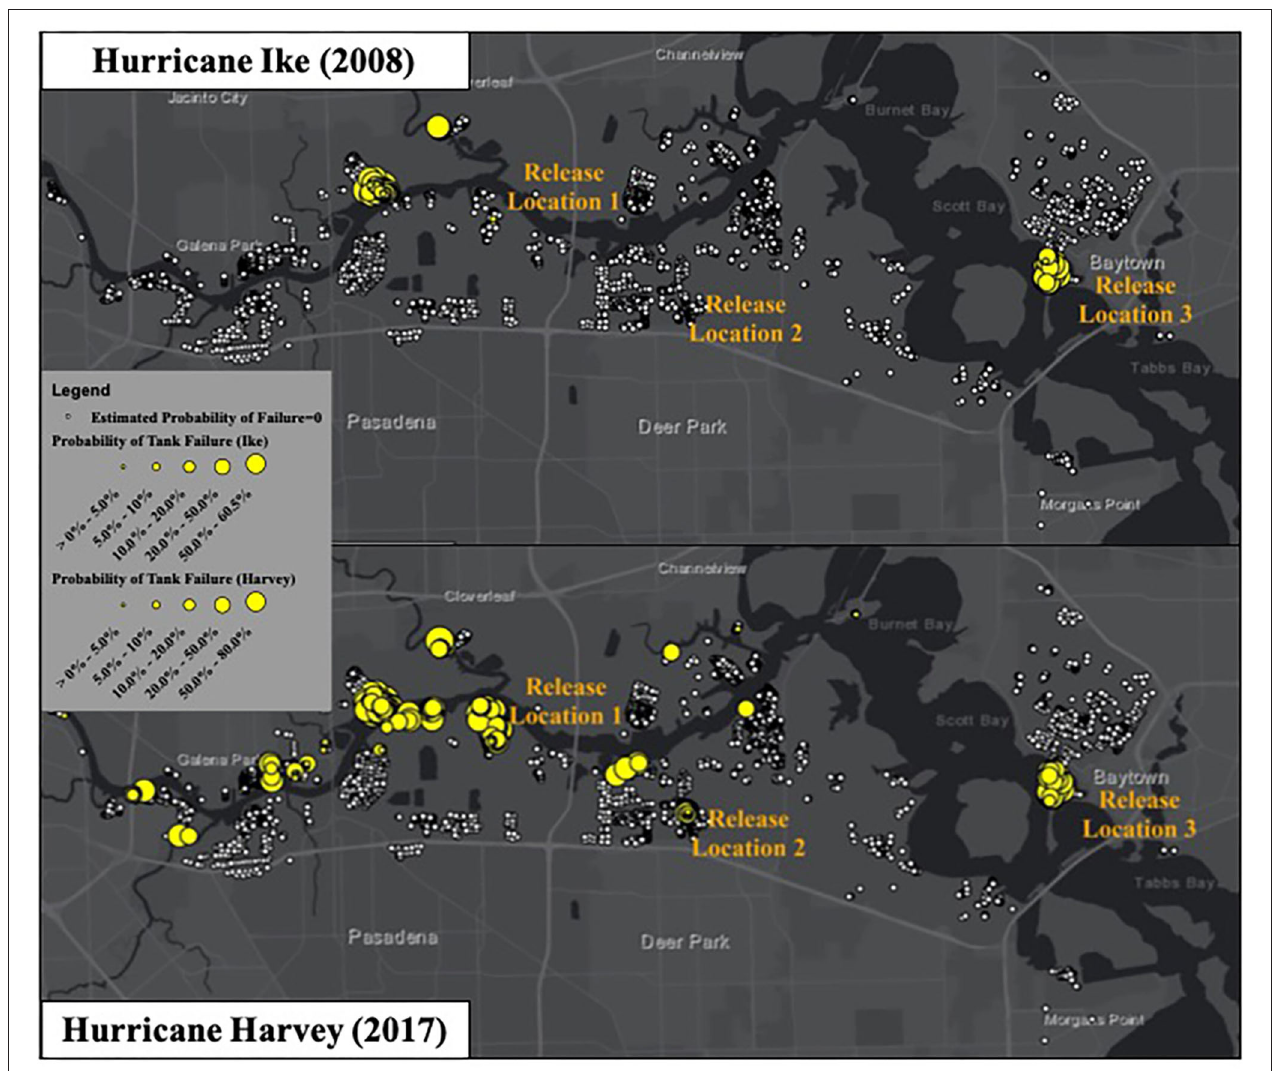
FIGURE 7 | Estimated probability of failure for the ∼ 4300 above ground storage tanks in the study area for Hurricane Ike (top) and Hurricane Harvey (bottom). Due to the absence of industrial tanks, the northern section of the domain (San Jacinto River, SJR area) is not shown.